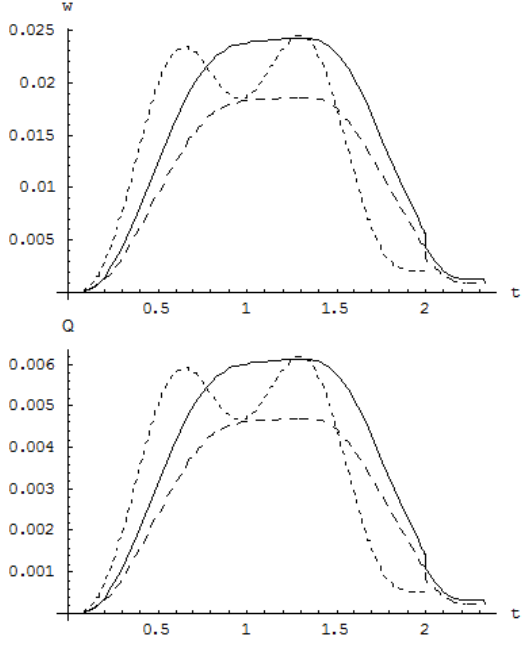
Figure 25: The vertical-torsional motion of the middle of the bridge (at x = L /2 ), for R = 100 m, υ = 30 m/s, e H = 3.00 m, e V = 1.20 m and three models of loading ( __ ) the real vehicle, (- - -) consequence of two loads, ( .... ) one concentrated load.